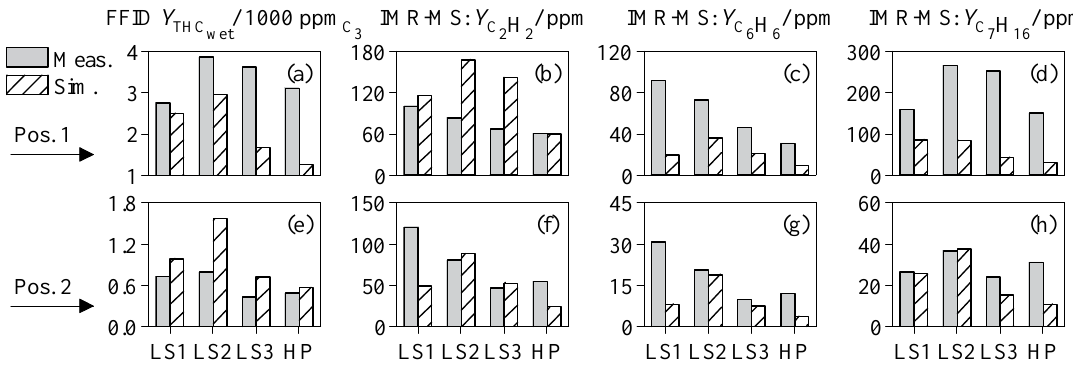
Figure 8. Comparison of average HC-emissions in Pos. 1 and in Pos. 2 between simulation (hatched bars) and measurements (FFID and IMR-MS) for all the operating points. FFID: ( a ) Pos. 1, ( e ) Pos. 2. IMR-MS: C 2 H 2 ( b ) Pos. 1 and ( f ) Pos. 2, C 6 H 6 ( c ) Pos. 1 and ( g ) Pos. 2, C 7 H 16 ( d ) Pos. 1 and ( h ) Pos.